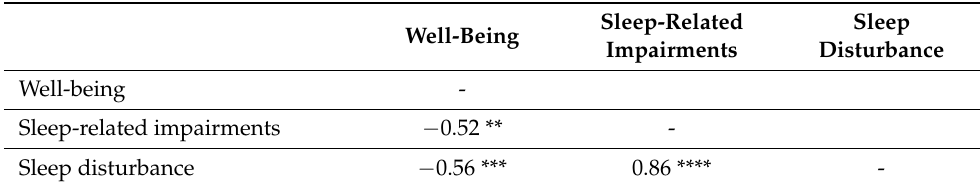
Table 7. The Spearman correlation ( r s ) between well-being, sleep-related impairments, and sleep disturbance. The highest correlation was found between SRI and SD measures, which focus on daytime sleep-related impairments and night-time sleep disturbances, respectively. Asterisks (**, ***, and ****) indicate p -values < 0.01, 0.001, and 0.0001, respectively. Sleep-Related Well-Being